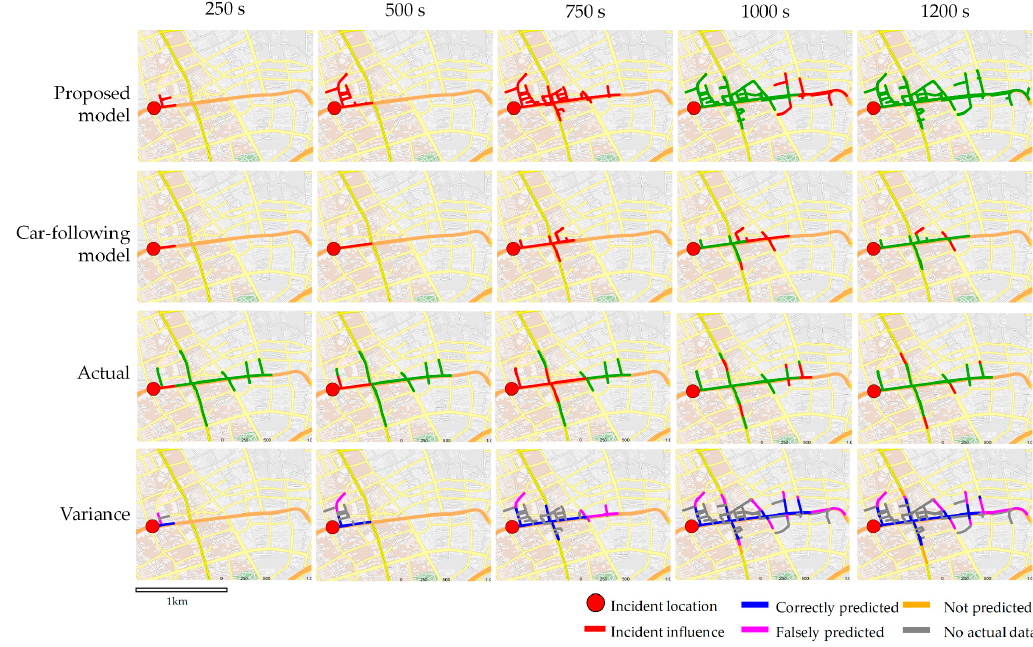
Figure 10. Spatiotemporal diagrams comparing the result of the proposed model, car-following model and actual data for Case B. The variance between proposed model and truth is shown in the fourth row.